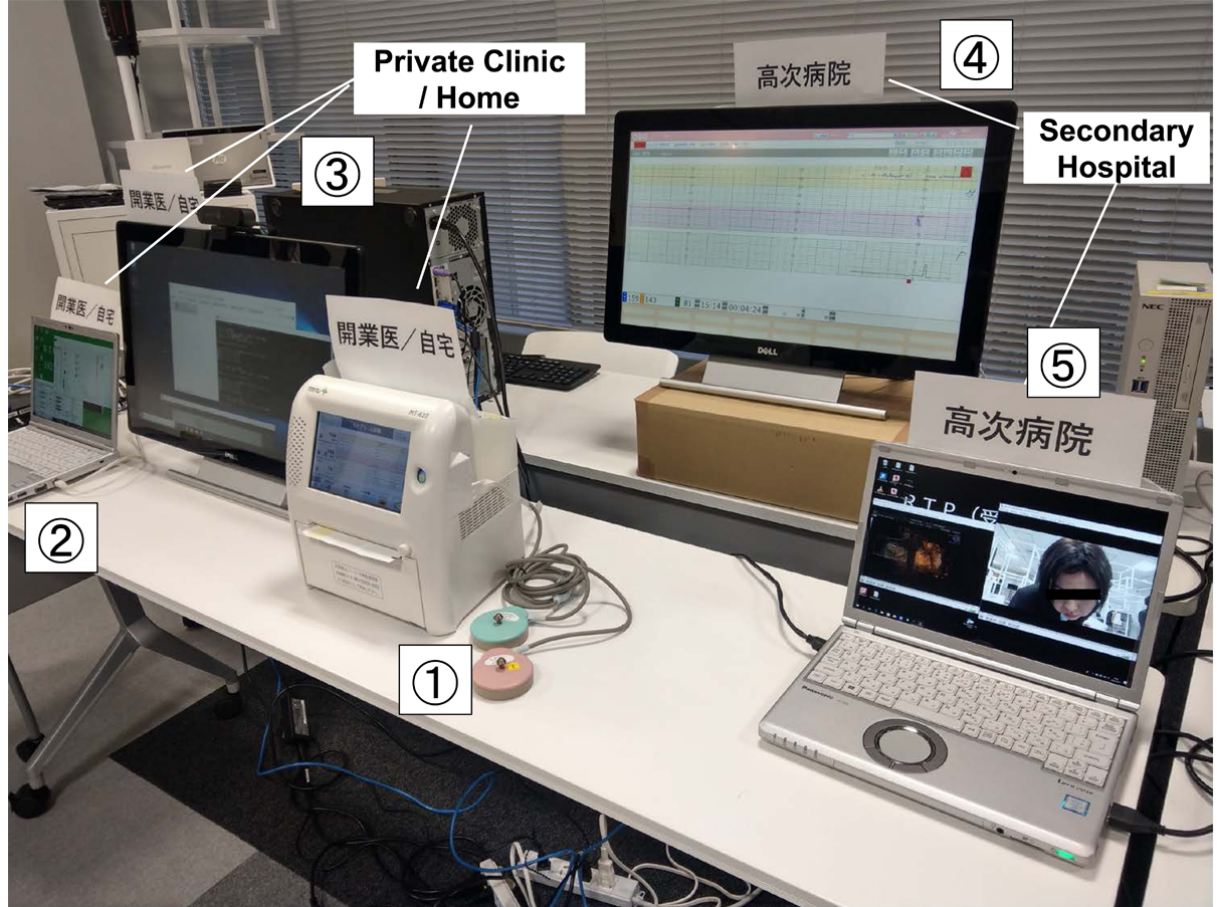
Figure 1. Panoramic view of the experiment. Objects 1-3 are the source side, and objects 4 and 5 are the receiving side of the 5G transmission system. 1: The cardiotocogram (CTG) device (MT-610) transmits the waveform of the fetal heart rate in clinical practice; 2: the computer plays back